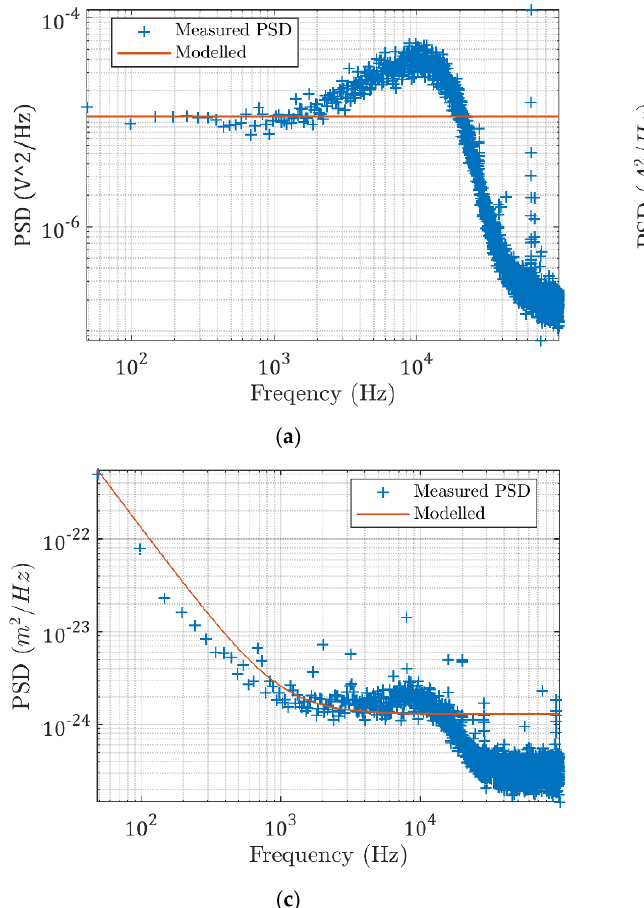
Figure 5. Measured ( a ) sensor noise ( b ), current loop noise, and ( c ) environmental vibrations and the modelled PSD functions.